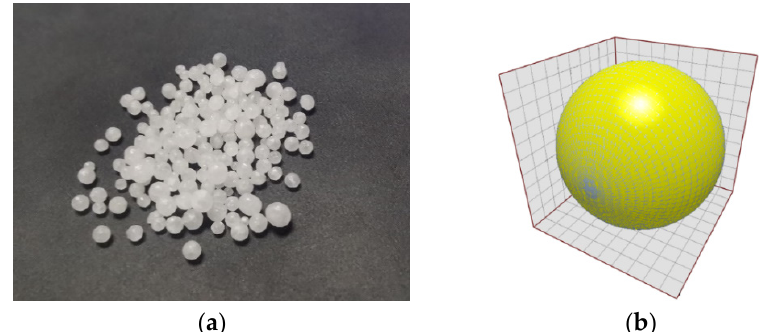
Figure 9. Urea particles and their discrete element model: ( a ) urea particles; ( b ) discrete element model for urea particles.